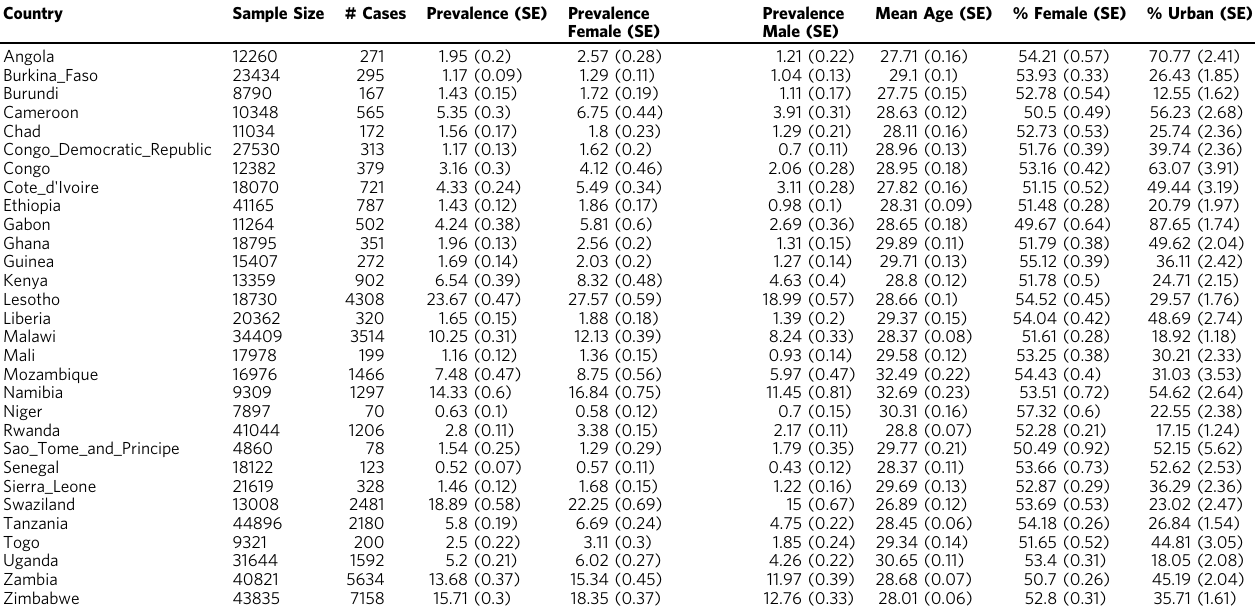
Table 1 Sample sizes across sub-Saharan Africa.